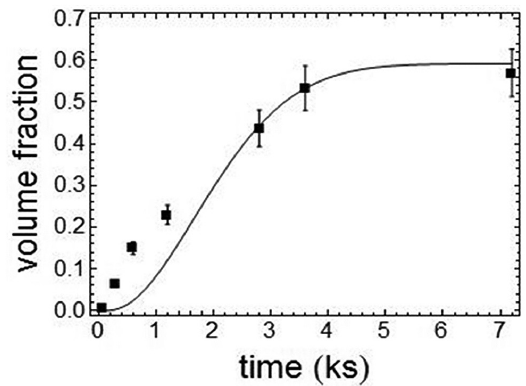
Figure 7. Comparison between volume fraction transformed of